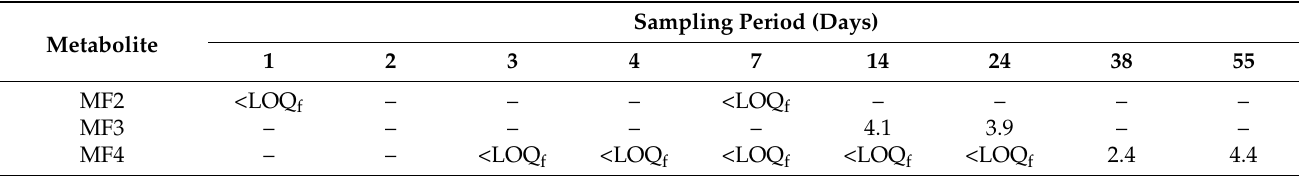
Table 4. Concentration ( µ g/kg) of unknown flutriafol metabolites under greenhouse conditions.